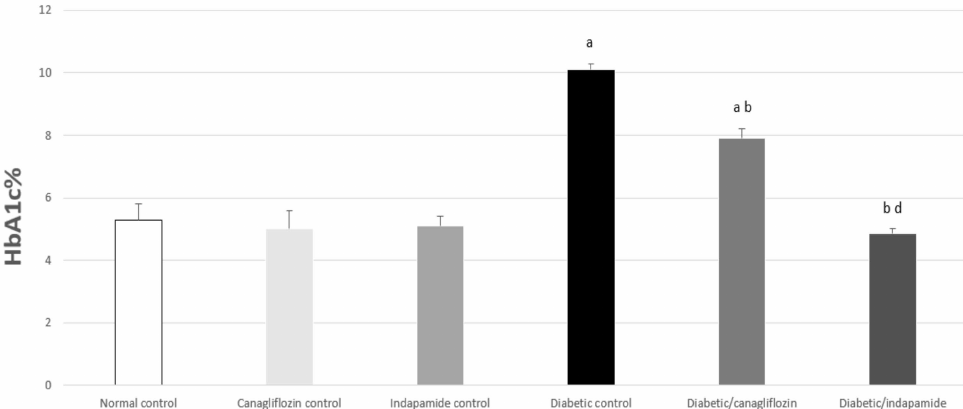
Figure 3. Impact of daily oral CANA and INDA treatment on HbA1c%: oral CANA and INDA treatments were initiated once daily for 4 weeks. Data represent the mean ± S.E.M. (6 rats/group). ANOVA followed by post hoc Tukey–Kramer test at ( p < 0.05) was used for statistical comparison; a against normal CTRL, b against diabetic CTRL, d against